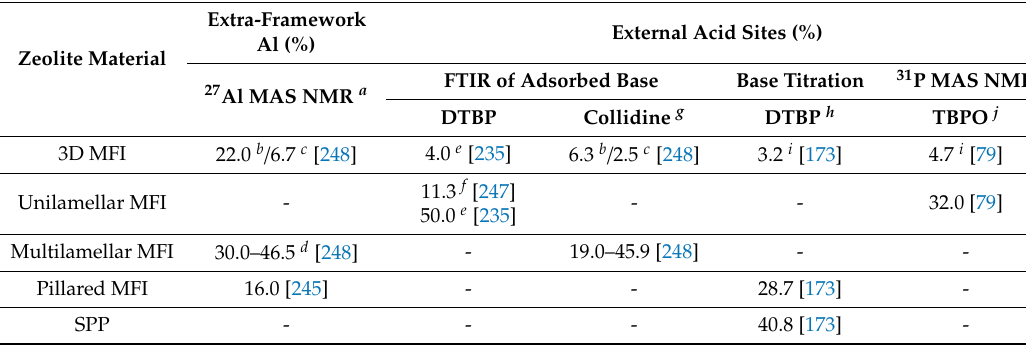
Table 11. Selected literature values of extra-framework Al and external acid sites in a 2D MFI zeolite probed by di ff erent